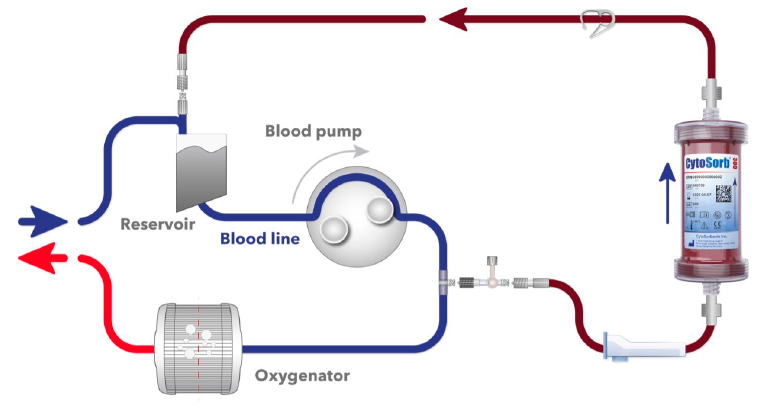
Figure 1. Illustration of the CytoSorb adsorber incorporated into the CPB